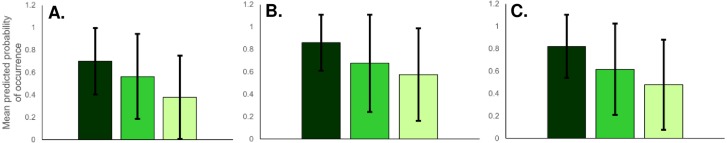
Predicted mean relative probability of occurrence of large carnivores in Romanian national parks (dark green bars), nature parks (medium green) and Natura 2000 sites (light green).Predictions are given for (A) Brown bear; (B) Gray wolf; and (C) Eurasian lynx. Error bars represent ± SD.